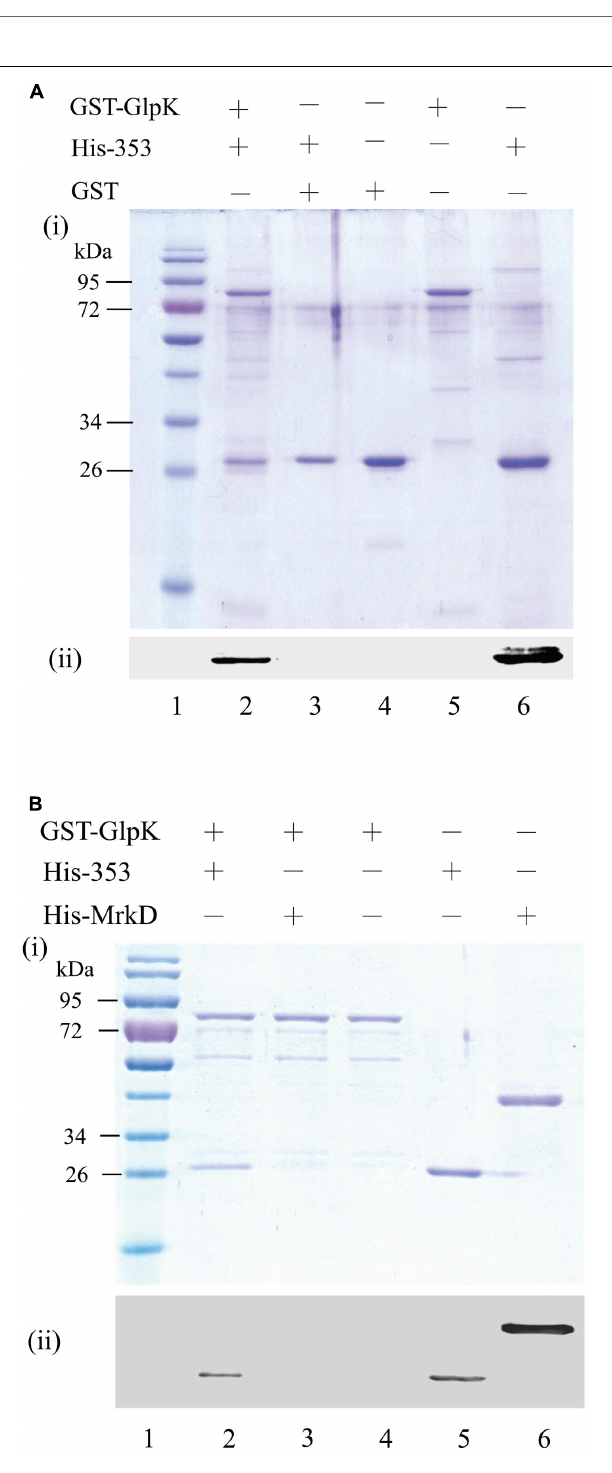
FIGURE 5 | Interaction between KPN00353 and GlpK. GST-tagged GlpK (GST-GlpK) was allowed to interact with His-tagged protein (lane 2, 3 in A,B ), and then the proteins captured on GSH-Sepharose beads were analyzed by (i) SDS-PAGE followed by Coomassie Blue staining and (ii) Western blotting using anti-His antibody. The purified proteins were analyzed simultaneously with the control (lane 4, 5, 6 in A,B ). The protein marker is shown in lane 1. His-353, His-tagged KPN00353; His-MrkD, His-tagged MrkD; GST, glutathione S-transferase.